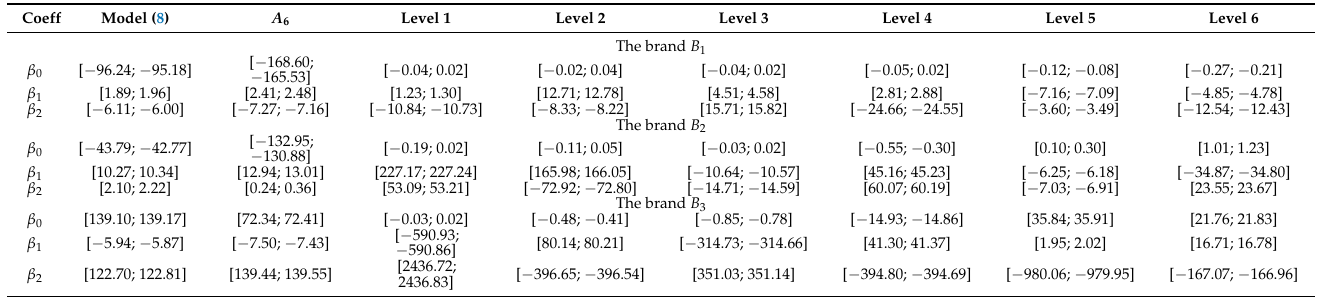
Table 6. Confidence intervals at 95% for model (9) coefficient estimations for brands B i , 1 ≤ i ≤ 6, at different levels.